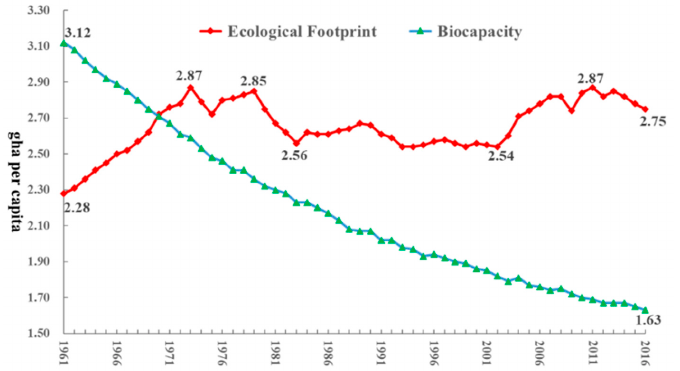
Figure 1. Temporal trends of global ecological footprint (EF) and biocapacity (BIO) (1961–2016). Data source: National Footprint Account results (2019 Edition) from the Global Footprint Network (GFN).